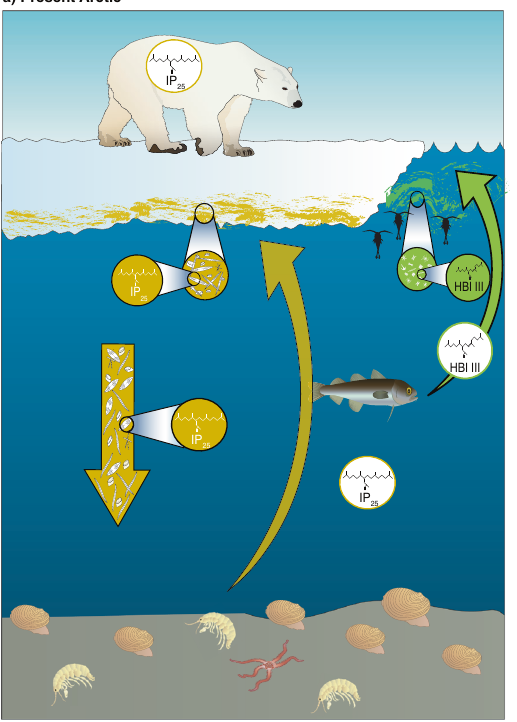
Fig. 4 | Schematic illustration of Arctic shelf sea ice-benthic coupling under current and future conditions. a The transfer of the sea-ice carbon, signi fi ed by the diatom biomarker IP 25 11 through the food web via sinking sea-ice algae, results in ‘ sea ice-benthic coupling ’ and the subsequent ‘ bottom-up ’ transfer of carbon from diverse sea fl oor fauna into pelagic consumers, in addition to the pelagic phytoplanktonbloomsigni fi edbythediatombiomarkerHBIIII 9 . b Afuturepelagic- dominated Arctic shelf scenario with extended open-water periods, ice-free sum- mersanddelayedblooms.Thepulsativedeliveryofsea-icecarbontothesea fl ooris